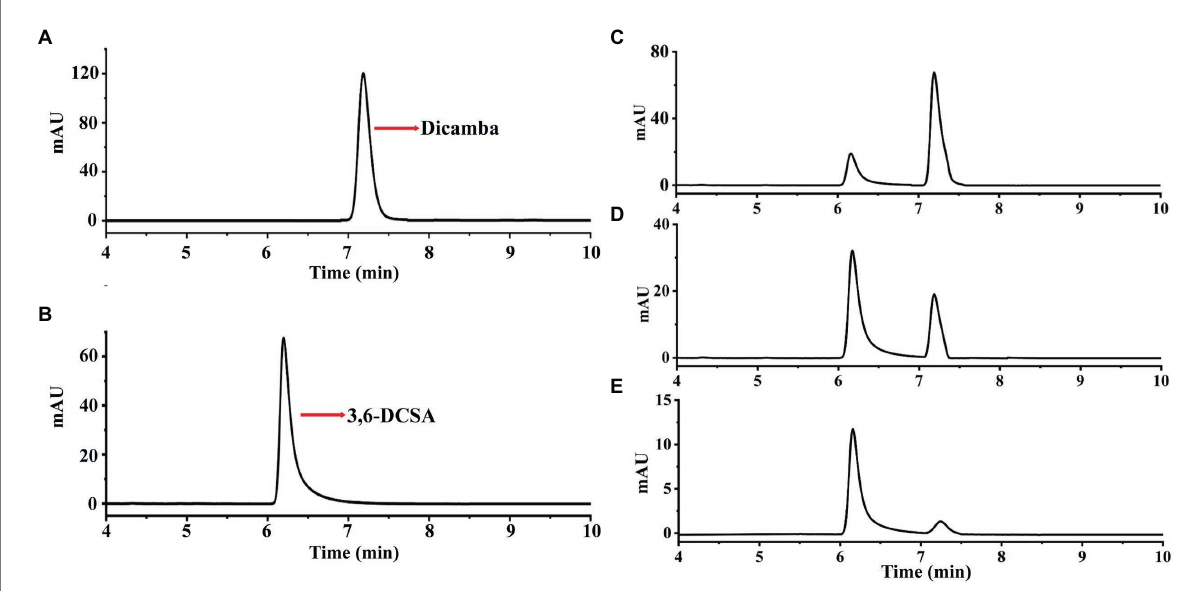
FIGURE 2 HPLC analysis of dicamba degradation by the enriched consortium. (A) The dicamba standard. (B) The 3,6-DCSA standard. (C) Sample collected at 4 h. (D) Sample collected at 8 h. (E) Sample collected at 12 h.